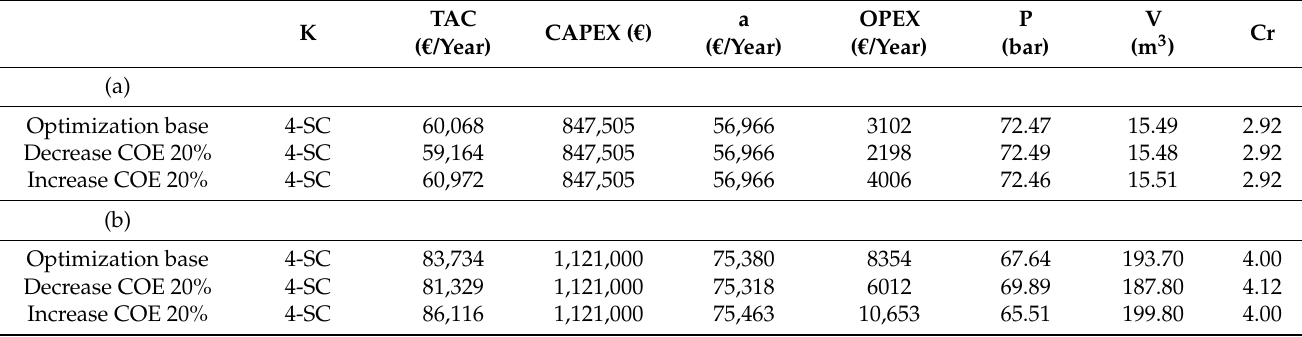
Table 10. Sensitivity analysis varying electricity price in comparison to optimized base case. (a) CO 2 ; (b) H 2 .